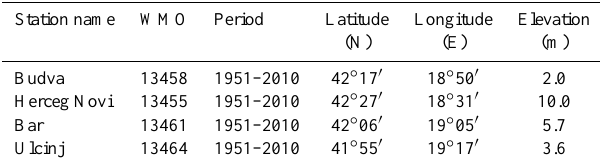
Table 1. List of the stations.